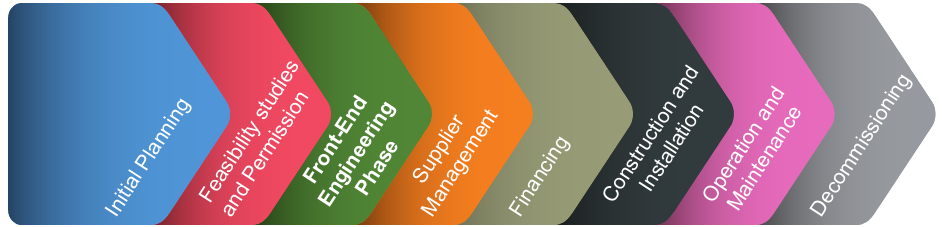
Figure 2. Lifecycle of an OWF and location of the FEED phase